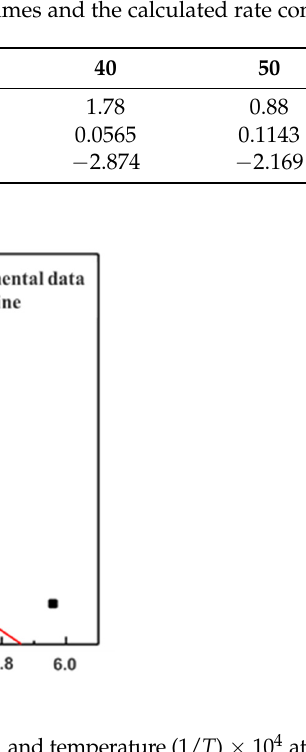
Table 8. The C content in the melt at different times and the calculated rate constants k 1 and lnk 1.